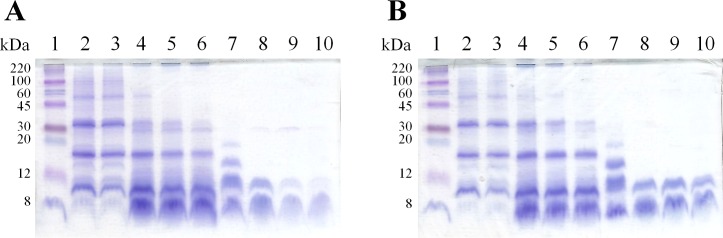
Mono-dimensional SDS-PAGE (16% w/v acrylamide) protein separation of digestates obtained with different E/S (U/g) ratios.(A) Alcalase and (B) Protamex hydrolysates after 2 hours of incubation. Loaded volume: 3 μL of total samples, 25 μL of supernatants. Loading scheme: lane 1) molecular weight markers; 2) ND, not digested total sample at room temperature; 3) ND 60°C, not digested total sample 2h at 60°C; 4) 0.5 U/g, total sample; 5) 1 U/g, total sample; 6) 2 U/g, total sample; 7) ND 60°C, not digested supernatant 2h at 60°C; 8) 0.5 U/g, supernatant; 9) 1 U/g, supernatant; 10) 2 U/g, supernatant.